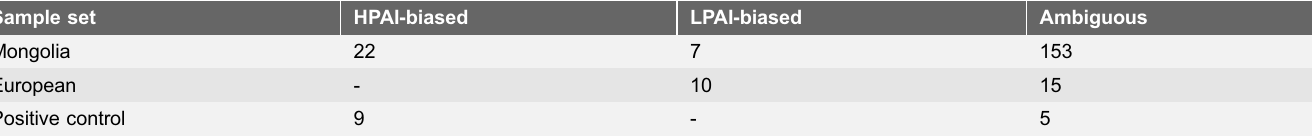
Table 4. Bias in serum titres.